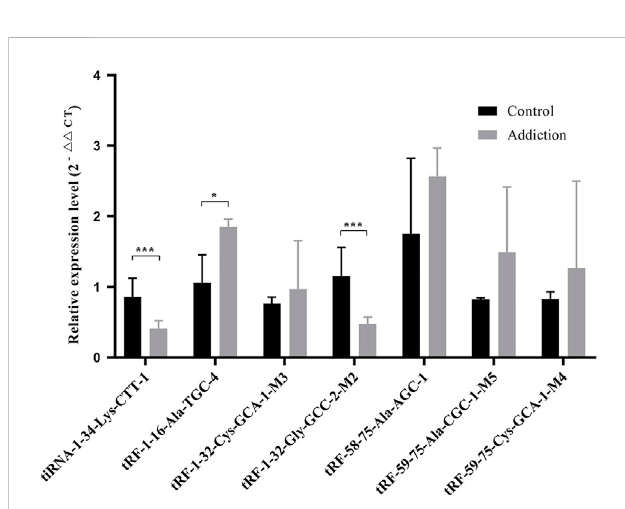
RelativeexpressionlevelsofseventRFsandtiRNAsvalidatedbyRT- qPCR. Data presents as means ± SEM, * p < 0.05, *** p <